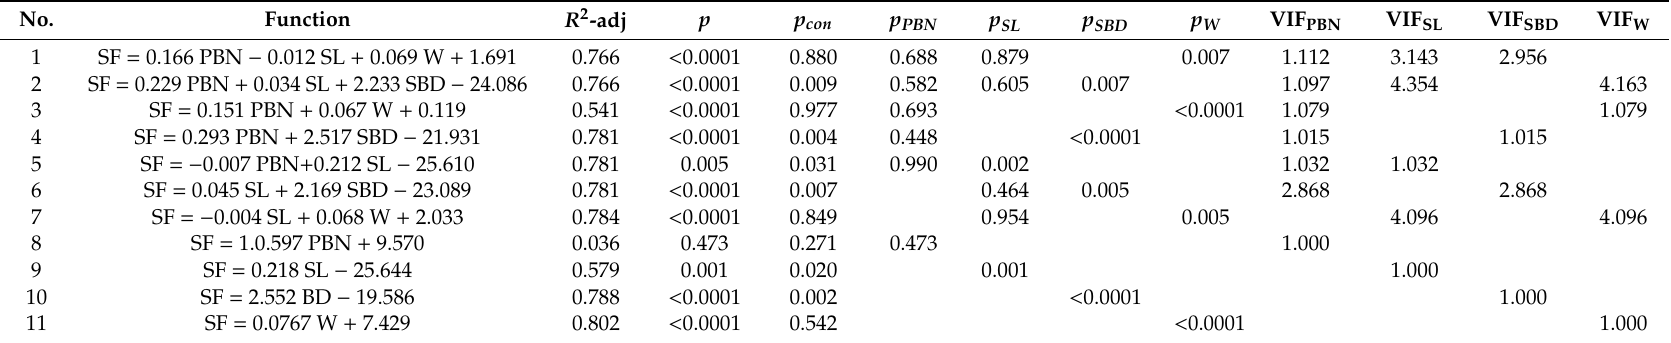
Table 2. Established linear regression models between sap flow and stem morphological variables using 70% of the whole